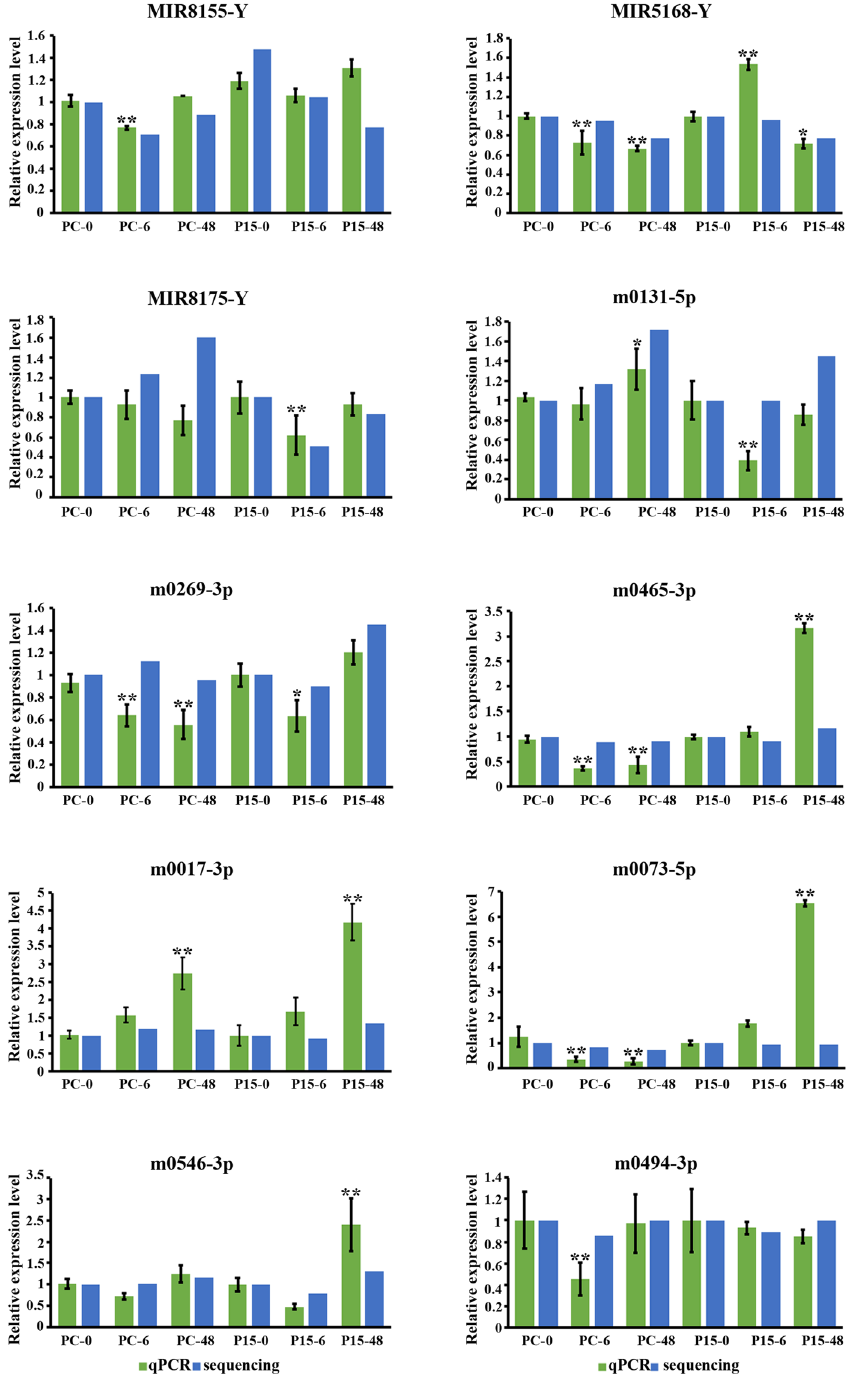
Figure 4. Stem-loop RT-PCR analysis of novel miRNA levels in P15 and PC compared to sequencing results. The expressions of miRNAs was normalized by small RNA U6. The data represent the mean ± SD from three biologically independent experiments. Statistical significance was analyzed using one-way ANOVA. The asterisks represent significance, where one asterisk indicates P ≤ 0.05, and two asterisks indicates P ≤